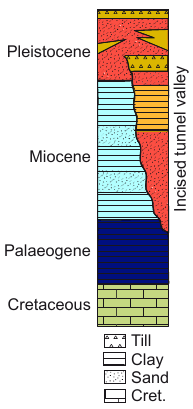
Fig. 3. Conceptual stratigraphical log for the survey area.